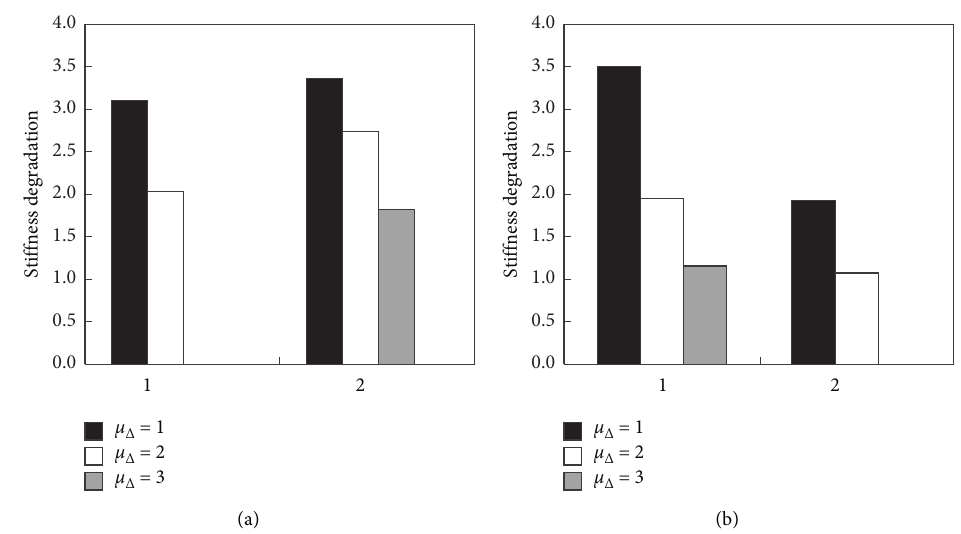
Figure 12: Stiffness comparison of joints (experimental results): (a) before reinforcement; (b) after reinforcement.